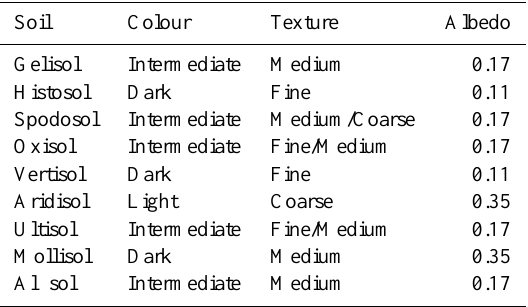
Table 1. The colour (for albedo) and texture translations for the soil orders used in the modelling of late Pliocene